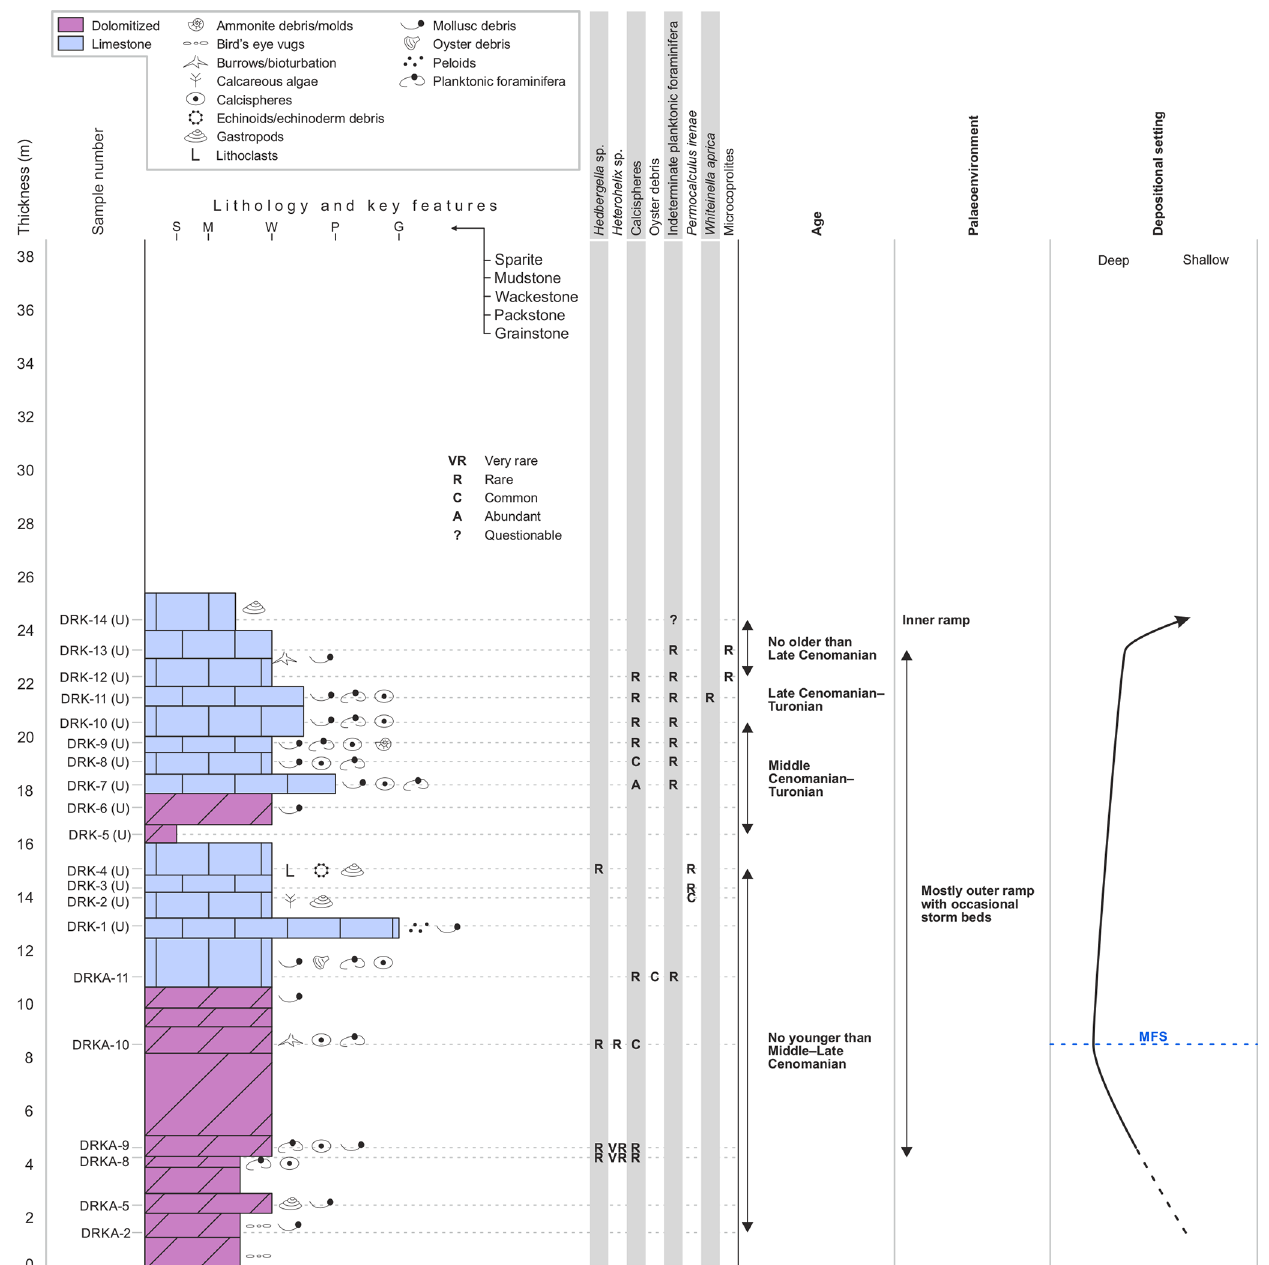
Figure 4. Upper Derdere Formation at Derik with sedimentological and petrographic information, micropalaeontology, age and palaeoenvi- ronmental interpretation, and identification of deposition trends. MFS stands for possible maximum flooding